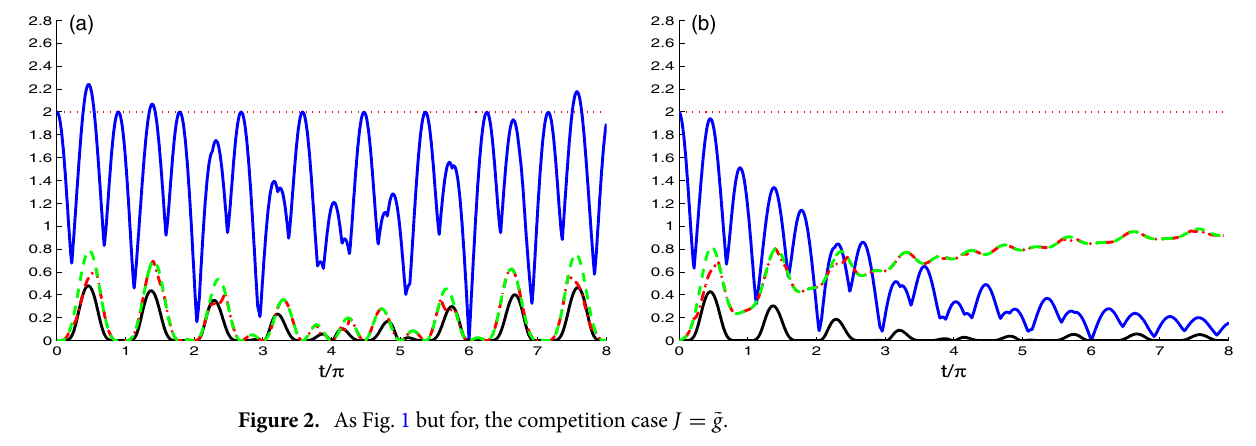
0.1 0.0 in ( a ) and χ g with different decay rate χ = ˜ = 1 1 0 2 g 1 g 2 �( 0 ) . | � = | �